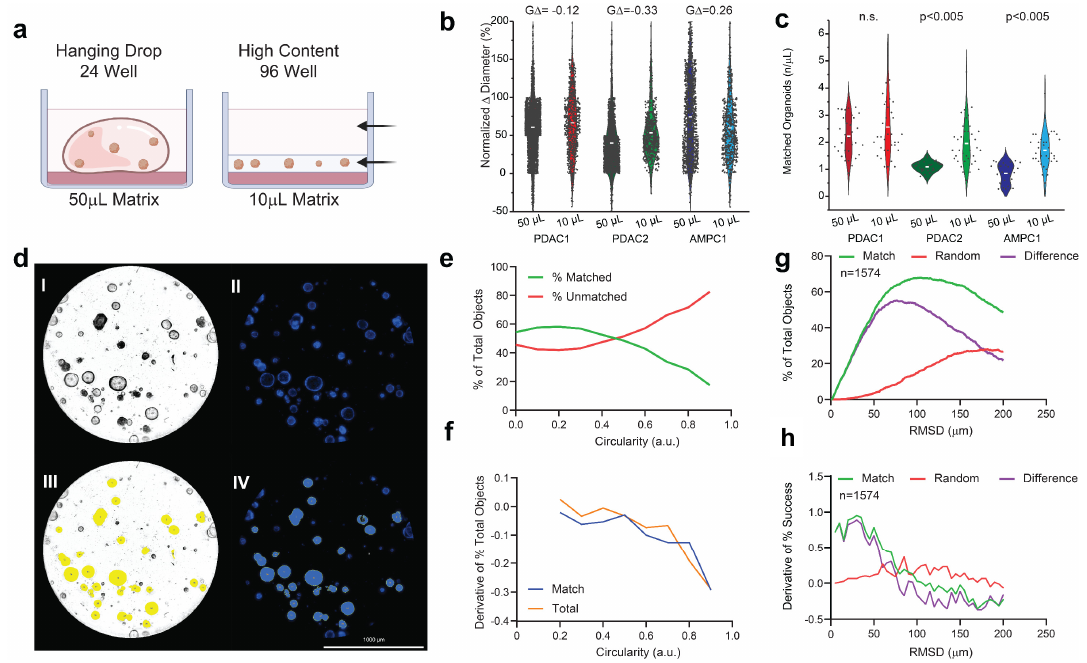
Figure 1. Evaluation of low − volume organotypic screening. ( a ) Design of traditional hanging drop format of the 50 µ L in 24 − well plates versus the adapted high − content design of the 10 µ L matrix in low − volume 96-well screening. ( b ) Violin plots of the normalized change in diameter for three established PCO organoid lines with effect sizes (G ∆ ) normalized to the traditional hanging drop. ( c ) Violin plots of the number of organoids established per µ L of the matrix with corresponding Student t − testing for each pairwise set. ( d ) AMPC organoids imaged in media-only, conditioned and assayed using an established marker for viability (Hoescht) at 72 h; scale bar is 1000 µ m, including ( I ) the brightfield image of AMPC1, ( II ) image of Hoescht-stained AMPC1, ( III ) object selection through Gen5 on the brightfield image, and ( IV ) object selection through Gen5 using only Hoescht staining. ( e ) The percentage of the total object population, matched and unmatched, across the continuous variable of the circularity index. ( f ) First derivative of change in objects for matched and total selected conditions across the circularity index. ( g ) Optimal RMSD is shown by the local maximum of the difference (purple) between the percentage of successful matches between two true inputs (green) and random assorted images (red). ( h ) First derivative of all three inputs to evaluate alignment, where match rate is surpassed by random